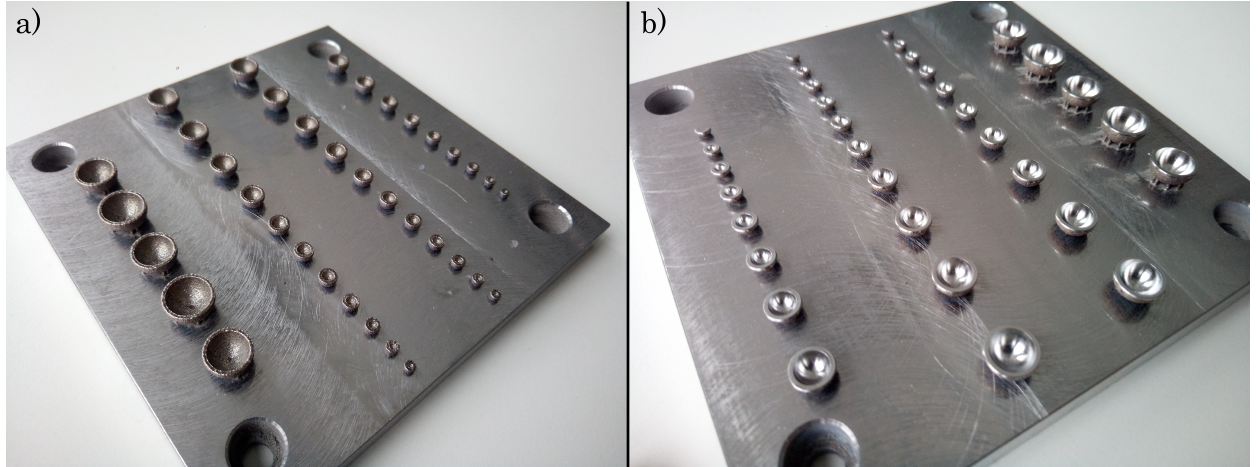
Figure 16. Comparison of ( a ) SLM-built and ( b ) hybrid built inner diameter of